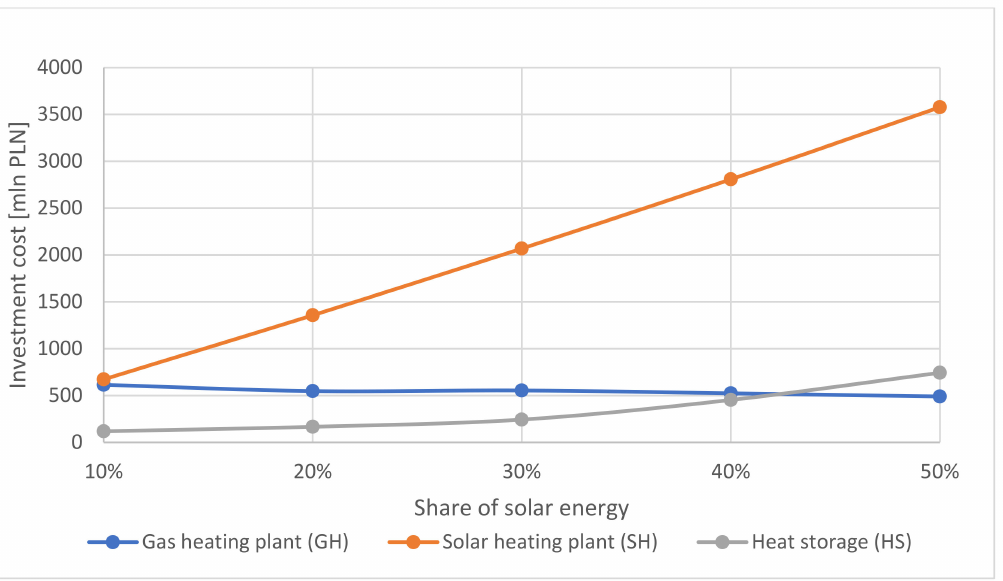
Figure 7. The amount of investment expenditures as a function of the share of solar energy. Explana-